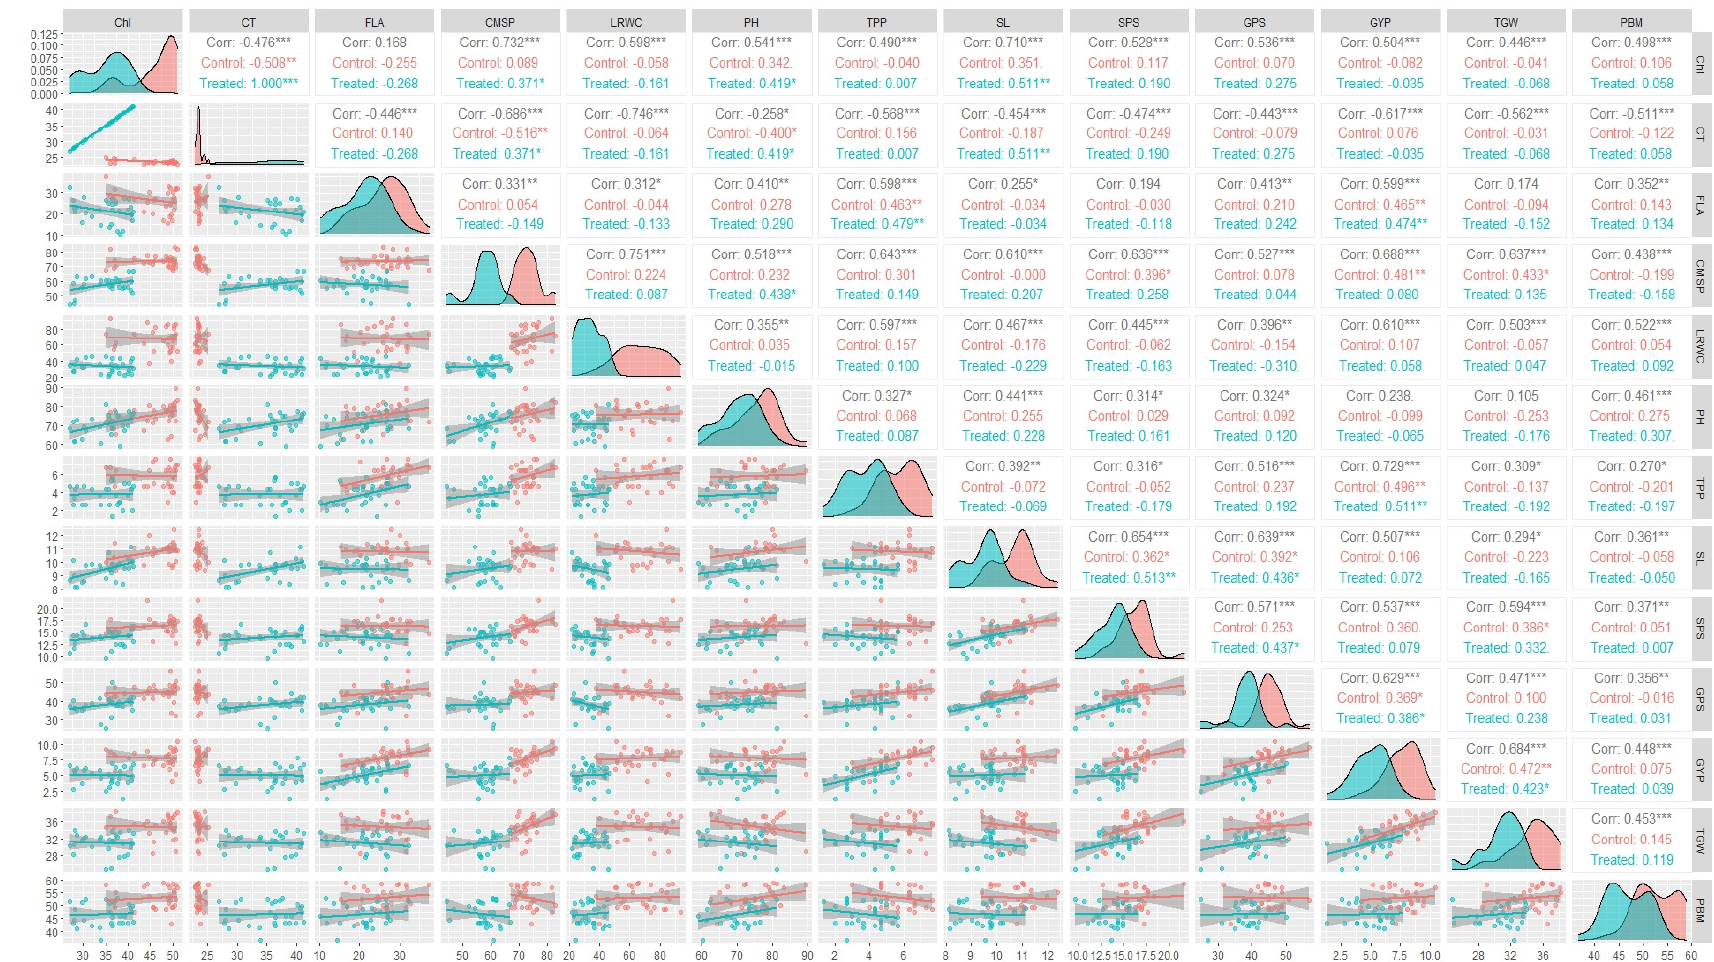
Figure 1. Effect of control and water stress conditions on the significance of association of physiological, growth and yield parameters of different wheat genotypes. Chl, chlorophyll; CT, canopy temperature; CMPS, cell membrane percentage stability; LRWC, leaf relative water content; FLA, flag leaf area; PH, plant height; TPP, tillers plant − 1 ; SL, spike length; SPS, spikelets spike − 1 ; GPS, grains spike − 1 ; GYP, grain yield spike − 1 ; TGW, thousand grain weight; PBM, plant biomass. *** = Significant at p ≤ 0.001; ** = Significant at p ≤ 0.01; * = Significant at p ≤ 0.05.